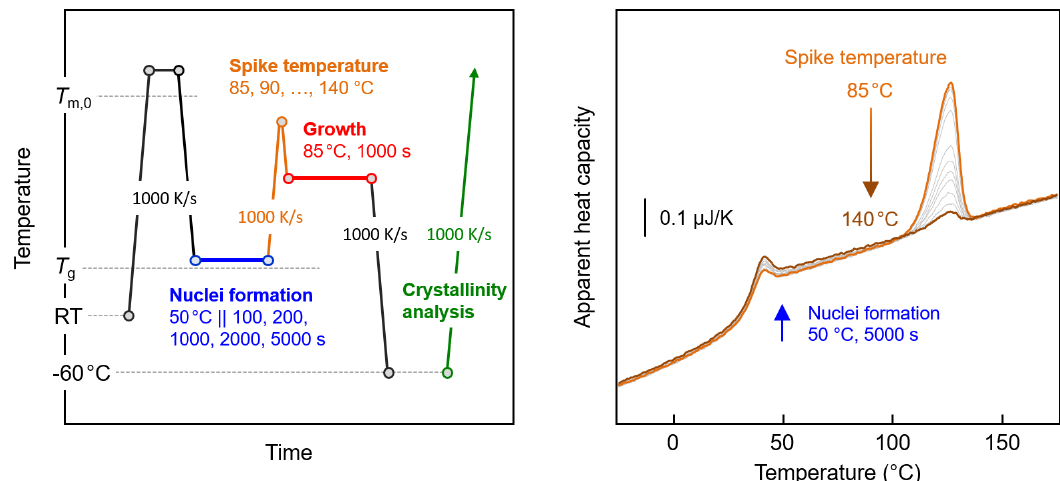
Figure 3. Temperature–time profile for the analysis of the thermal stability of crystal nuclei formed at 50 °C for different times ( left ). FSC heating curves after subjecting the polymer to nucleation at 50 °C for 5000 s, followed by heating to a pre-defined maximum temperature between 85 (orange curve) and 140 °C (brown curve), and the growth of nuclei to crystals at 85 °C for 1000 s ( right ). The gray curves are associated to maximum spike temperatures of 90, 95, 100, 105, 110, 115, 120, 125, 130, and 135 °C.